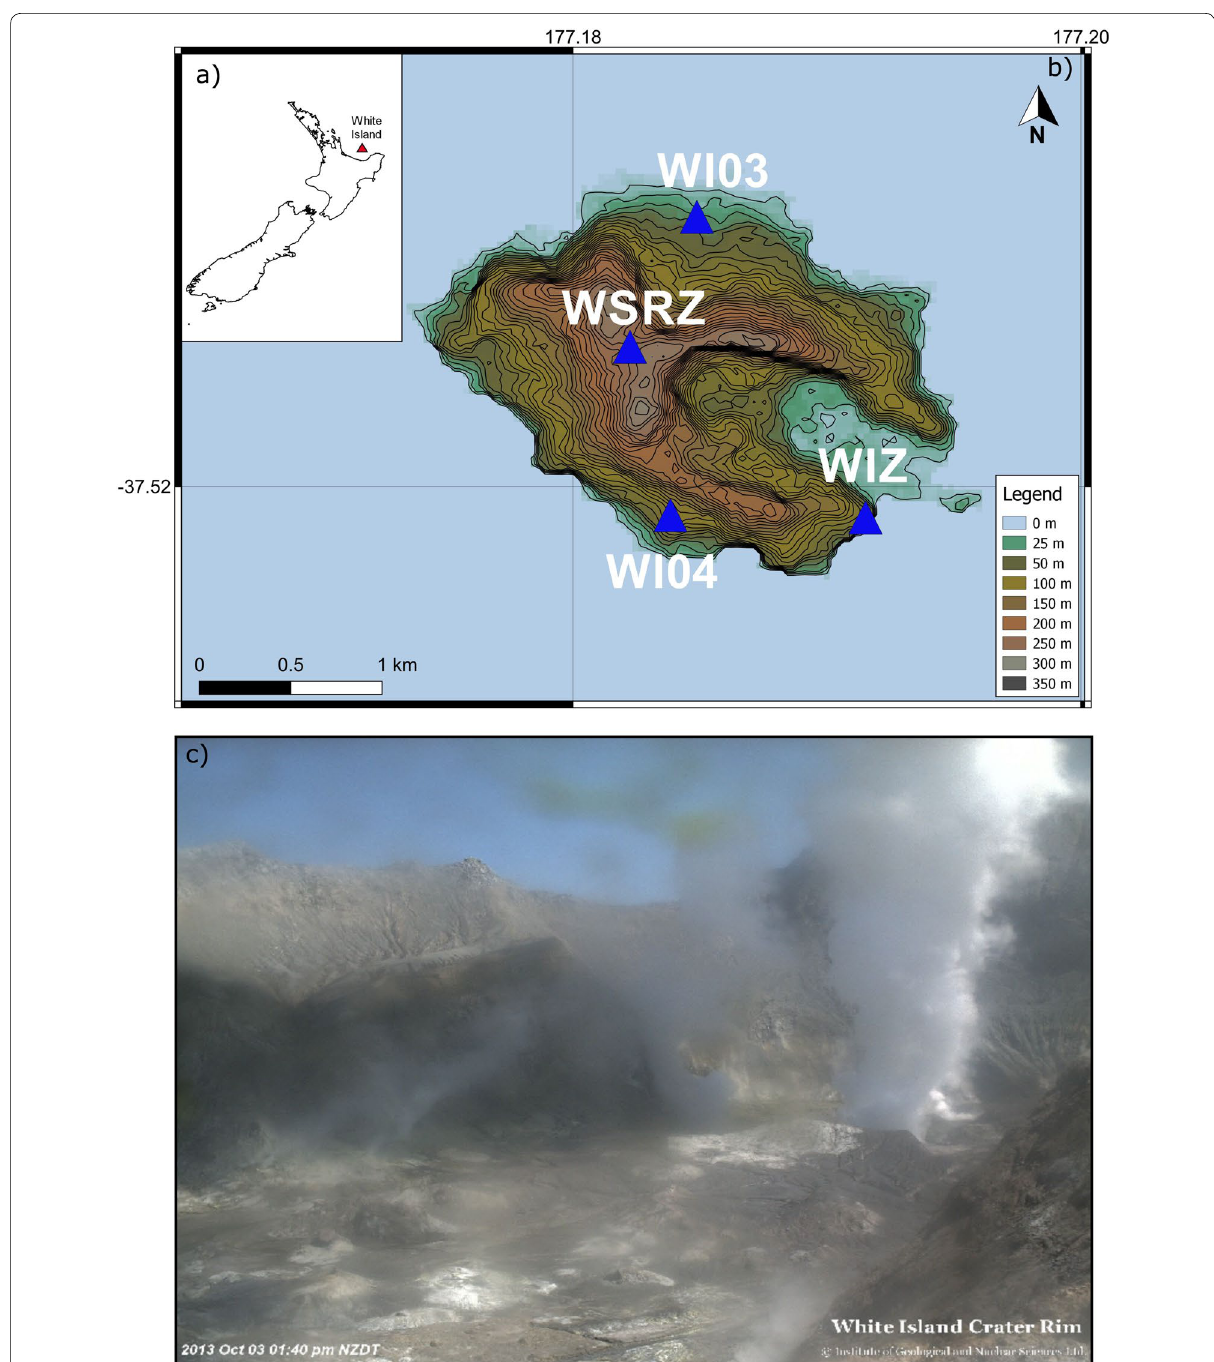
Fig. 2 White Island phreatic eruption and seismic network. a White Island location in New Zealand. b Locations of broadband seismic stations used in this study. c Photograph taken during the phreatic eruption on 3 October